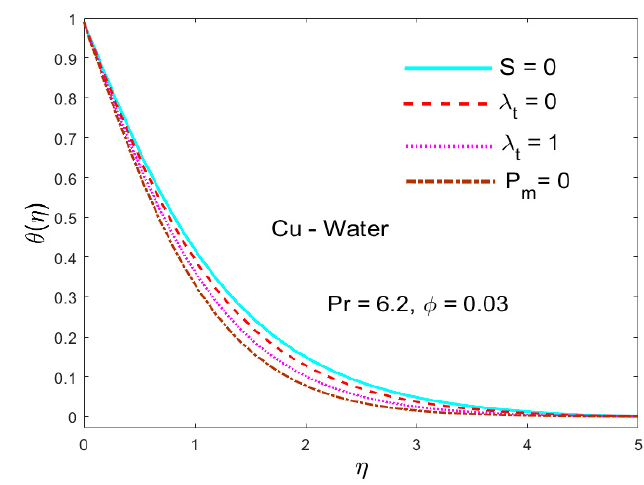
Figure 8. Effect of λ t , S and P m on temperature field.